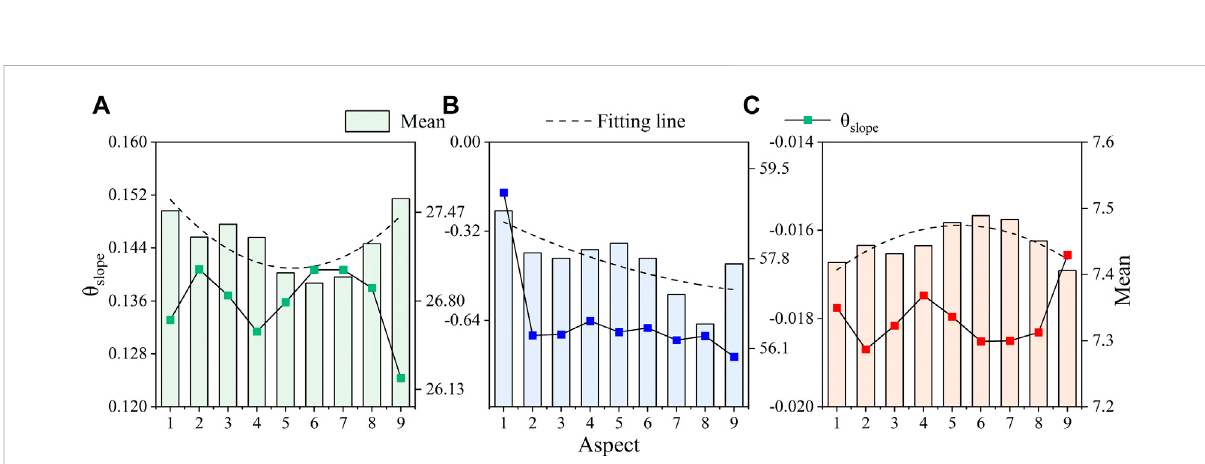
FIGURE 11 Effect of aspect on soil water – salt: (A) effect of aspect on SWC, (B) effect of aspect on EC, and (C) effect of aspect on pH. Note: 1 – 9 represent north, northeast, east, southeast, south, southwest, west, northwest, and north, respectively; constrained conditions: elevation of 3,400 – 3,600 m and slope of 4 ° – 8 °